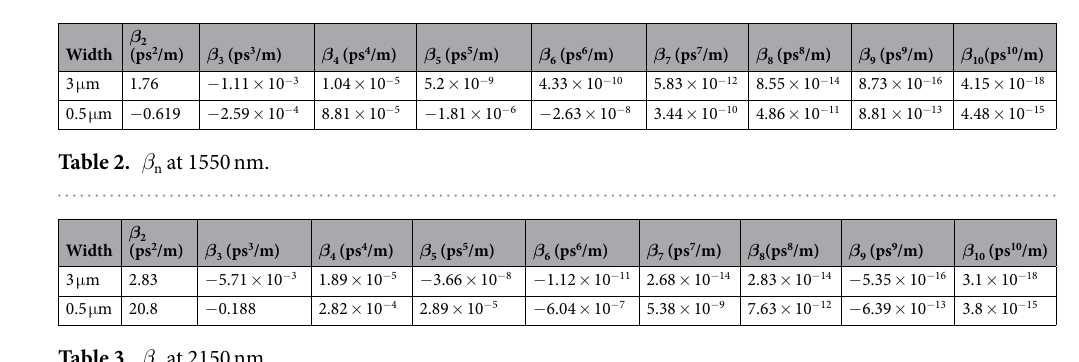
2 of the material is obtained by polynomial fitting to the experimental data